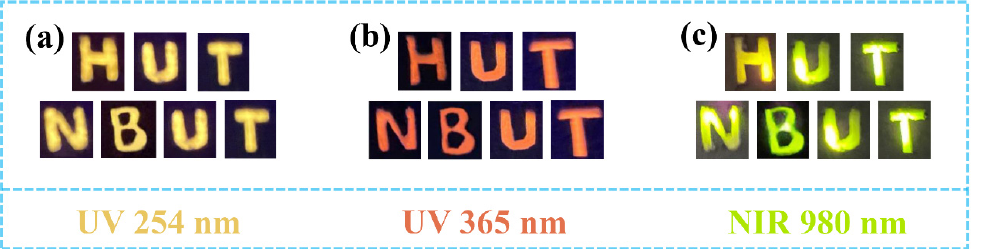
Figure 7. Anti-counterfeiting images of Cs 2 Ag 0.3 Na 0.7 InCl 6 : 100%Yb 3+ /100%Eu 3+ /60%Ho 3+ . The pat- tern was excited under UV 254 nm ( a ), UV 365 nm ( b ), and NIR 980 nm ( c